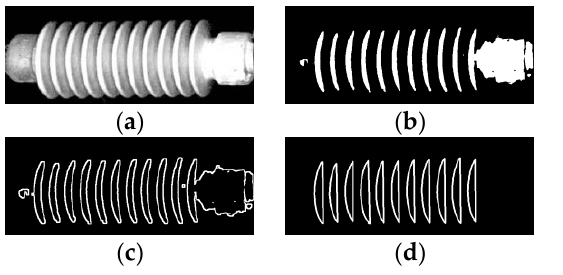
Figure 6. Results of image preprocessing. ( a ) original image; ( b ) binarized image; ( c ) the whole contour; ( d ) the contour of the insulator pieces.